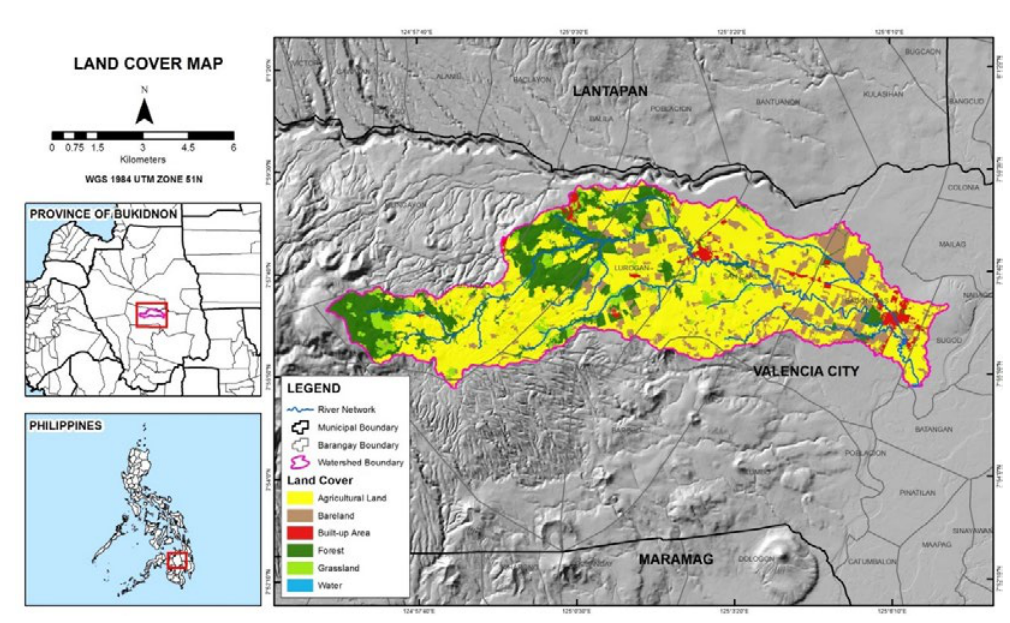
Fig. 5: Malingon River basin land cover map 2016